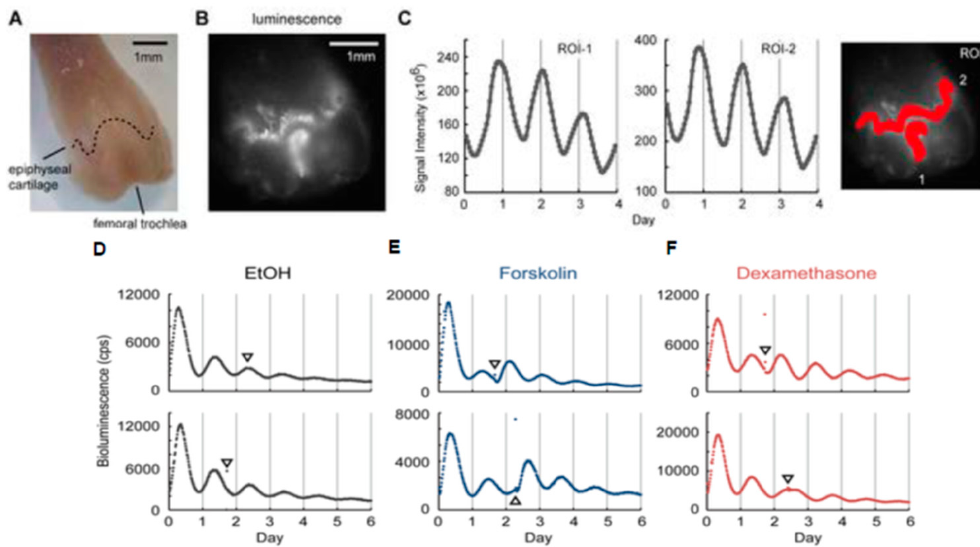
Figure 3. Bioluminescence imaging of circadian rhythms in Per2-Luc mouse femur. ( A ) The overview of the distal half of the femur. The dotted line indicates epiphyseal cartilage. The mirror-reversed image was used for comparison to the bioluminescence image. A sample was obtained from a 16.5-week old mouse and cultured for 6 days before observation. ( B ) The bioluminescence image obtained by a microscope-based high sensitivity CCCD camera system. ( C ) A time series analysis of the epiphyseal cartilage ( ROI-1 ) and femoral trochlea ( ROI-2 ). The right panel shows set ROIs. ( D–F ) Effects of forskolin and dexamethasone (DEX) on circadian clocks. Representative data showing the phase advancement ( upper panels ) or phase delay of the bone circadian clock ( lower panels ). The arrowhead indicates chemical administration. From left to right, the vehicle (ethanol; EtOH) ( D ), DEX ( E ), or forskolin ( F ). Reproduced with permission from [30] .